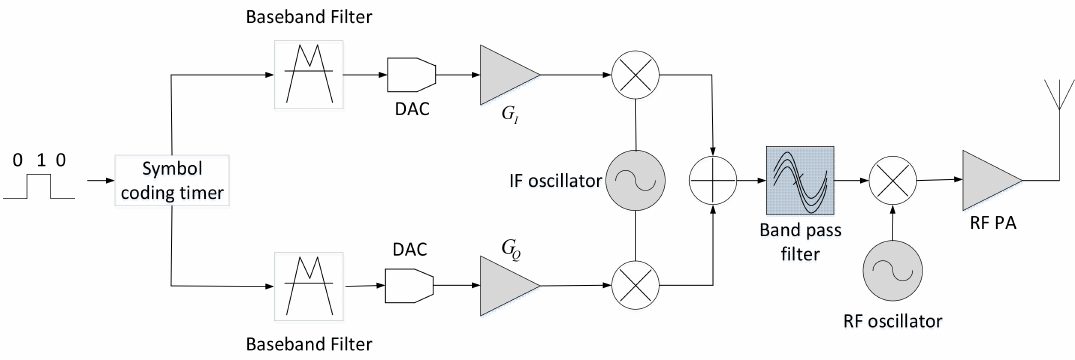
Figure 3. Phase-modulation flowchart.